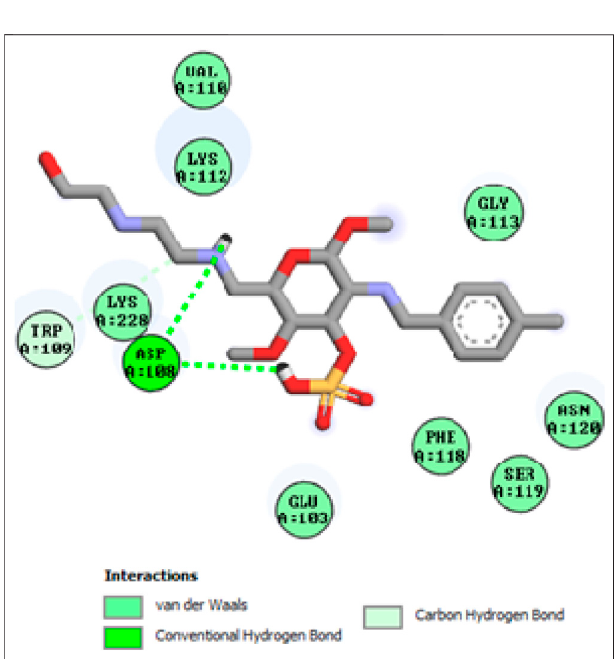
FIGURE 6 | Interaction of compound 2b in the binding pocket of 1Z11